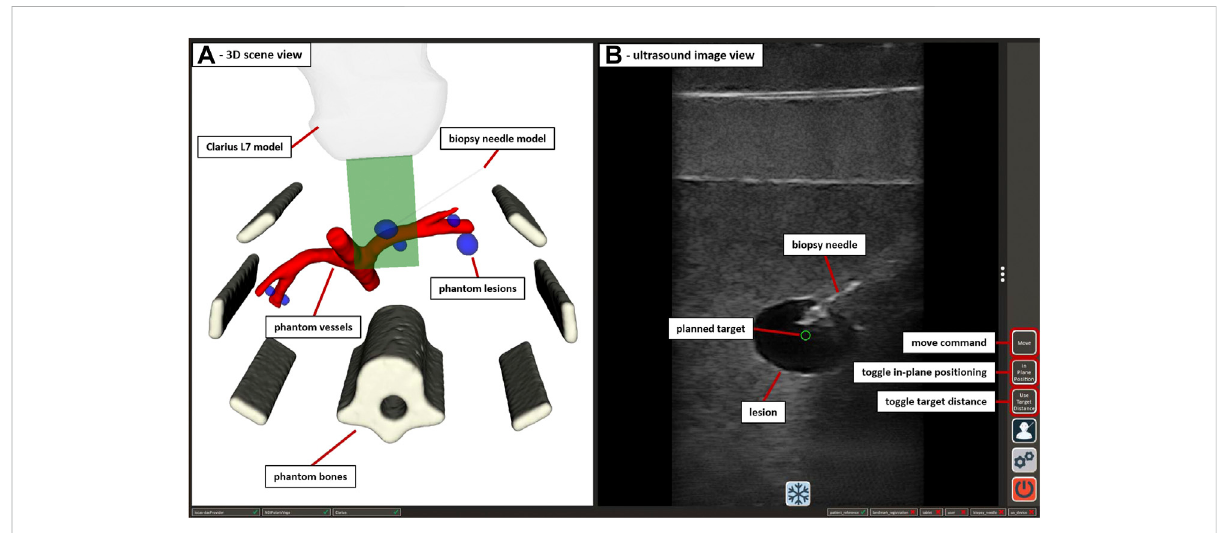
FIGURE 5 TheGUIoftheUS-guidedbiopsyapplication. (A) displaysthe3DsceneviewcontainingthesegmentedCT/MRI dataoftheabdominalphantom used in Section 2.3.3 and 3D representations of the used end-effectors. (B) shows the US image view with the planned target position (green circle) andtheimageofaninsertedbiopsyneedle.InteractiveGUIelementsformovementcommandsandswitchingbetweenpositioningmodesarelisted in a toolbar at the right